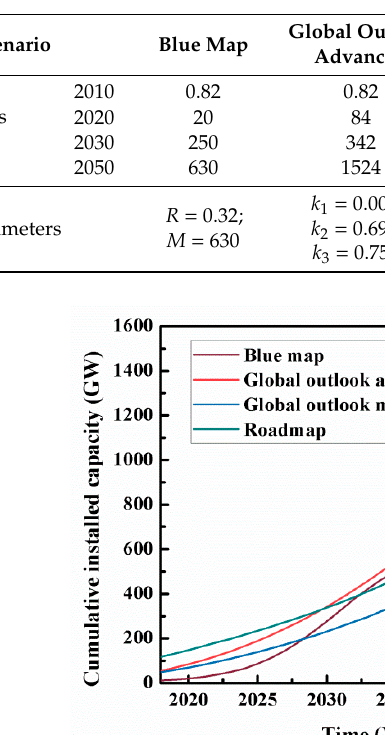
Table 2. Cumulative installed capacity objectives of CSP systems in International Energy Agency (IEA) scenarios and the parameters of their fitting functions.